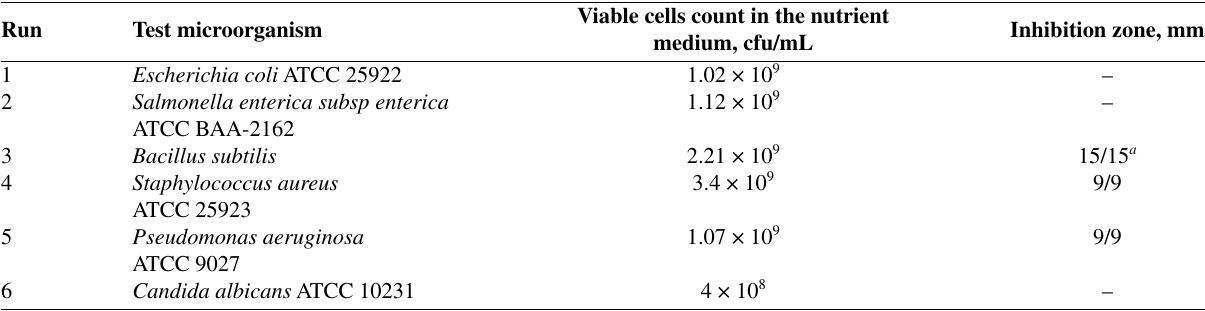
Well diameter: 6 mm a inhibition zone with single cell